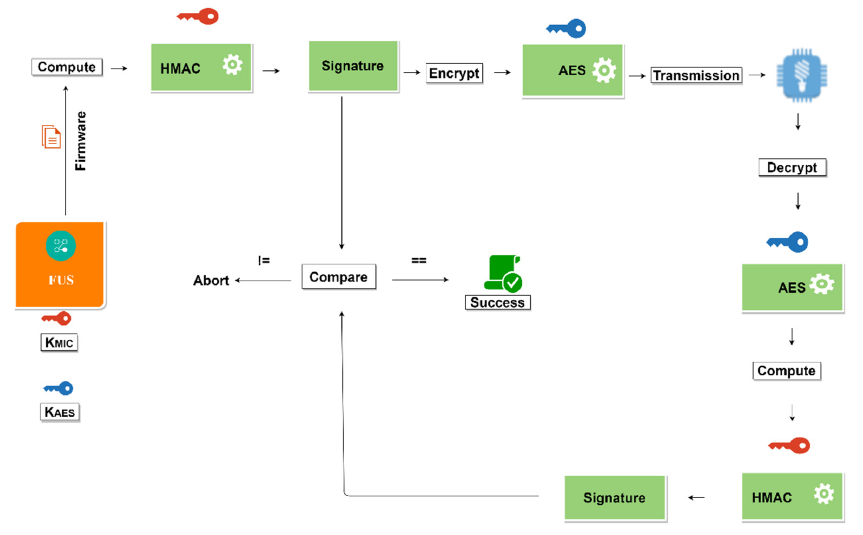
Figure 9. Firmware Verification on the End Device.